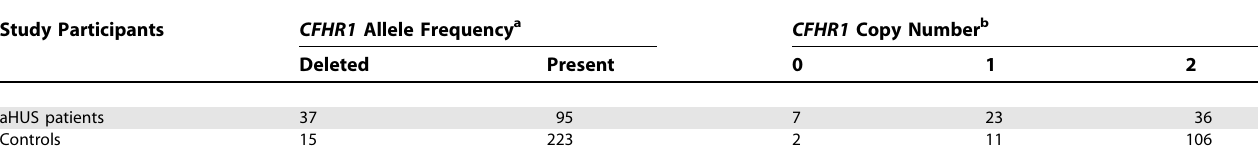
Table 1. Frequency of CFHR1 Deletion and Copy Number of CFHR1 Exons 2 and 3 in aHUS Patients and Controls (Newcastle Cohort) Study